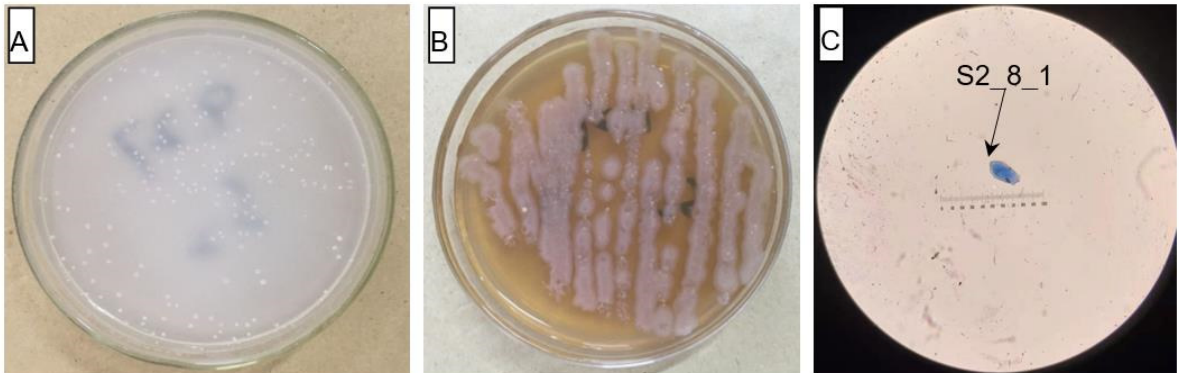
Figure 4. Cell and colonial morphology of strain S2_8_1 in the study. The S2_8_1 was the strain that has been isolated and screened in the present study. ( A ) and ( B ) Showed the morphology characteristics of cell and colony of strain S2_8_1 in separation and LB mediums, respectively. ( C ) Showed the size and sharp of strain S2_8_1, respectively.